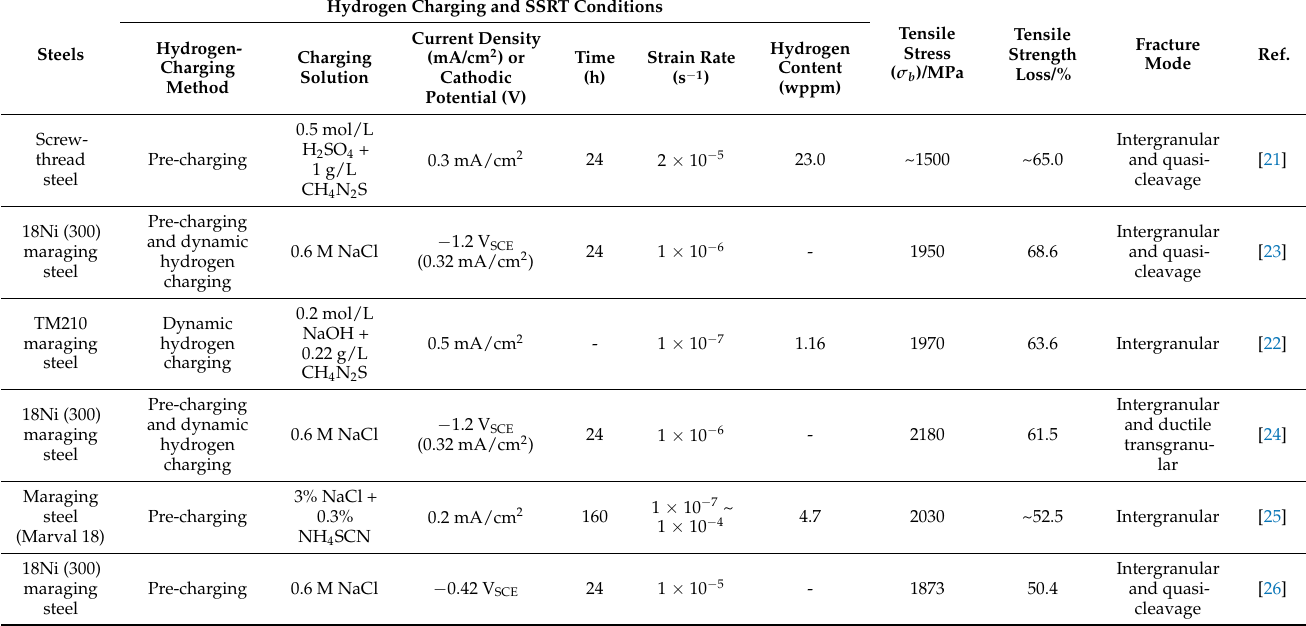
Table 3. Summary of strength loss, hydrogen charging, SSRT conditions, and fracture modes of other high-strength steels after hydrogen charging from the literature. Note that all the specimens were electrochemically hydrogen charged, and all the SSRTs were conducted at room